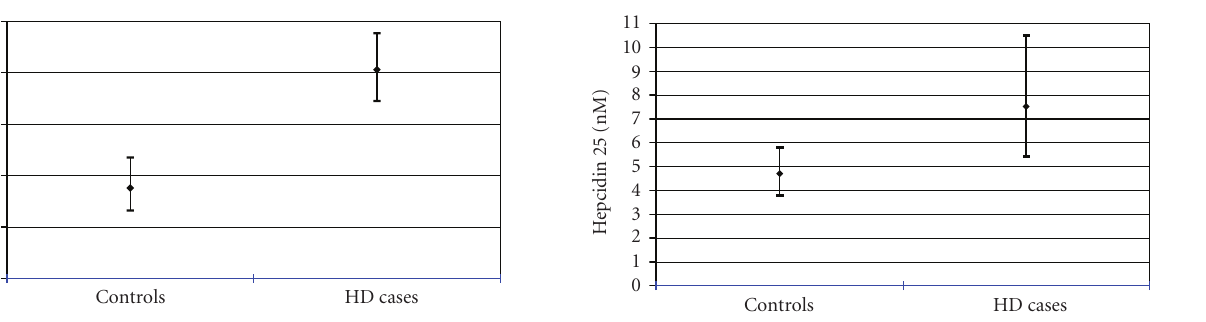
Figure 3: Hepcidin-25 in controls and HD patients. Data presented as geometric mean with 95% confidence